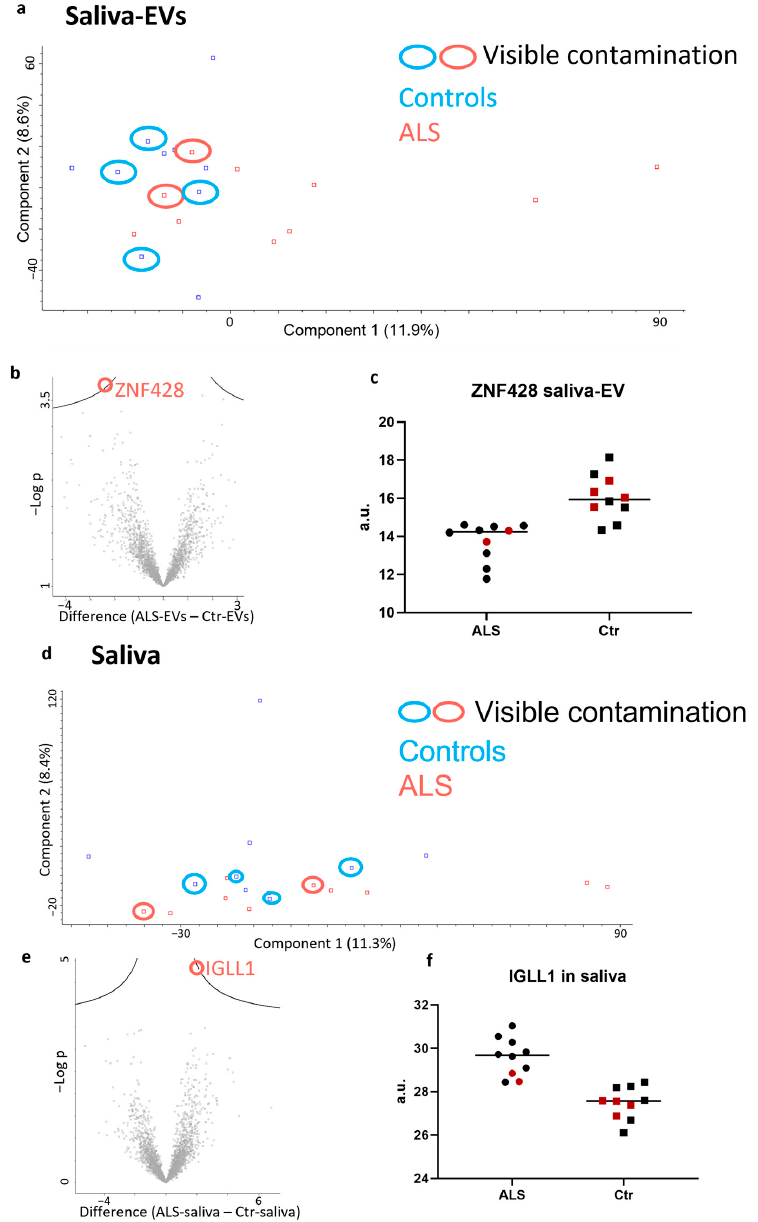
Figure 6. Proteomic analysis of saliva-EVs and cleared saliva. ( a ) There was no clear clustering of the samples based on principal component analysis and the contamination did not appear to affect the results. ( b ) There was no statistically significantly expressed protein between the groups, as de- picted in a volcano plot, but there was a trend towards downregulation of ZNF428 in ALS saliva- EVs ( c ) black dots represent ALS samples, black squares control samples and red dots or squares represent samples with visible contamination. ( d ) Similarly, for saliva samples, there was no obvi- ous clustering of the samples based on principal component analysis. ( e ) No proteins were statisti- cally significantly expressed, although IGLL1 showed a complete separation between patients and